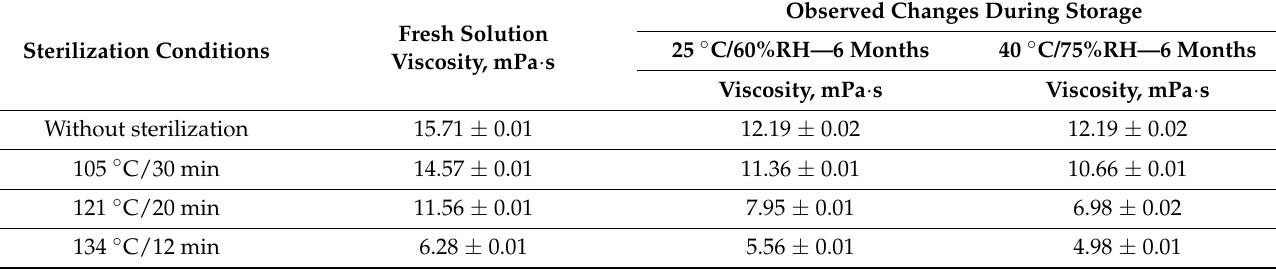
Table 8. Change in viscosity of 0.4% HA solutions in NaCl after sterilization and during storage under accelerated and long-term test conditions (mean ± SD, n =